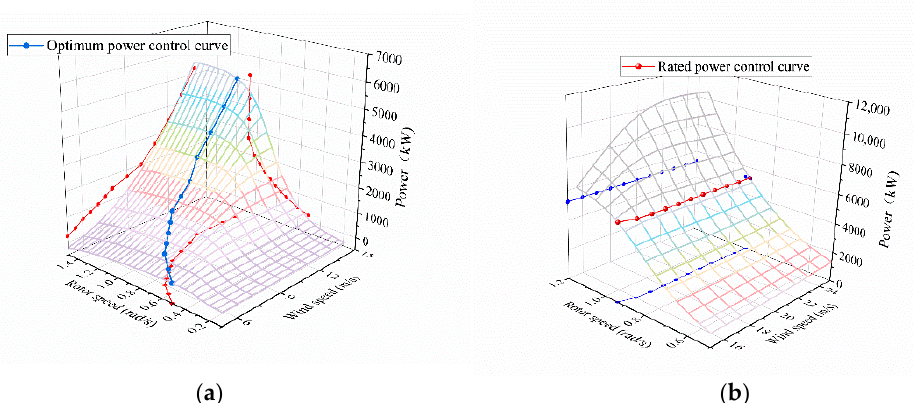
Figure 6. Output power via different wind speeds and rotor speeds. ( a ) Vw = 5–15 m/s; ( b ) Vw = 16–25 m/s.